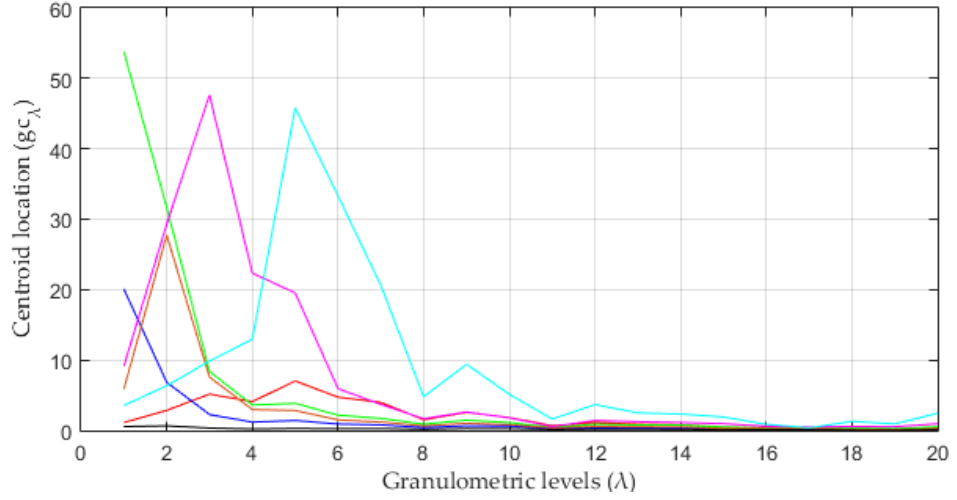
Figure 6. Granulometric profiles of 7 classes from 20 granulometric levels. Guileyni, 2011.